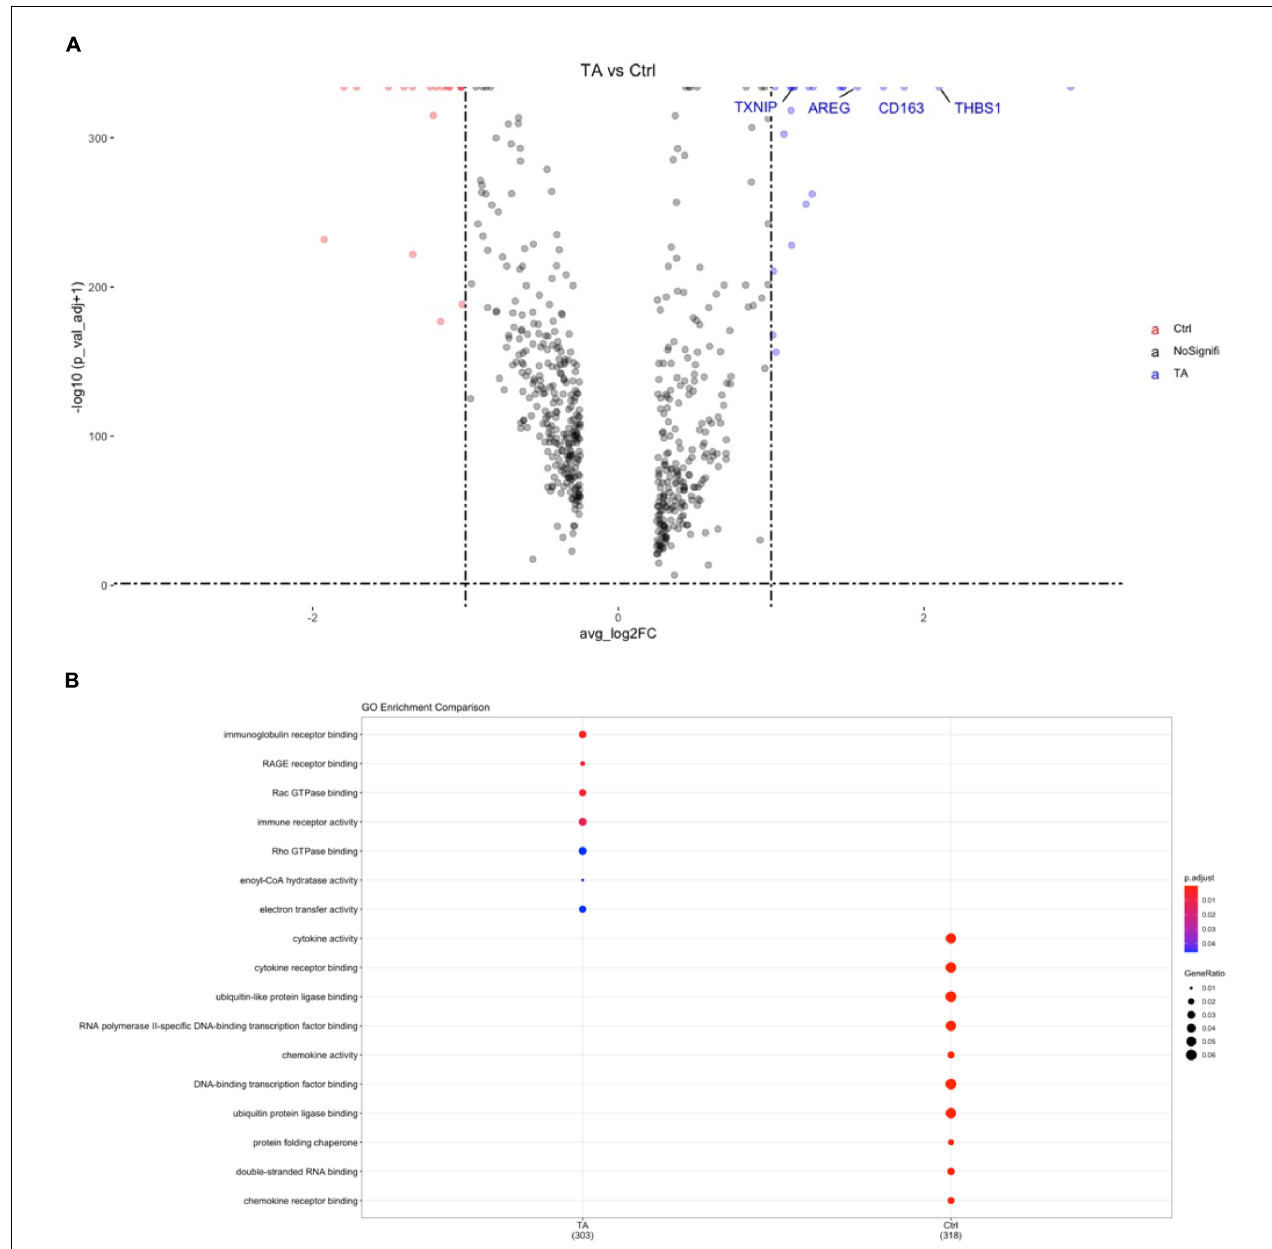
FIGURE 3 | (A) Volcano plot for gene expression of cell markers in PBMCs between TA and Ctrl group. TXNIP, AREG, THBS1, CD163 were significantly higher in TA group. (B) GO analysis of CD14 + monocytes. RAGE pathway can be found in TA